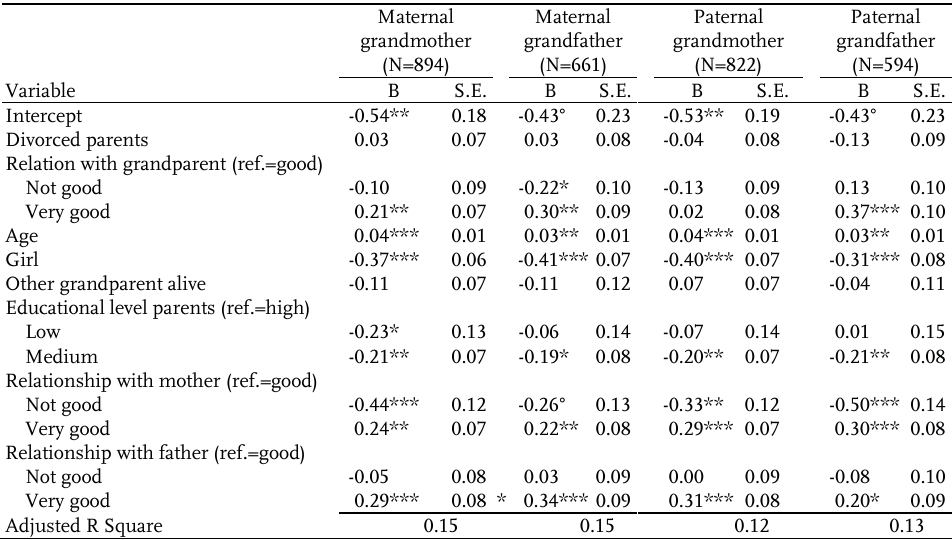
Table A.2 : Linear regression analyses of grandchildren’s self-esteem, sample including grandchildren with divorced and married